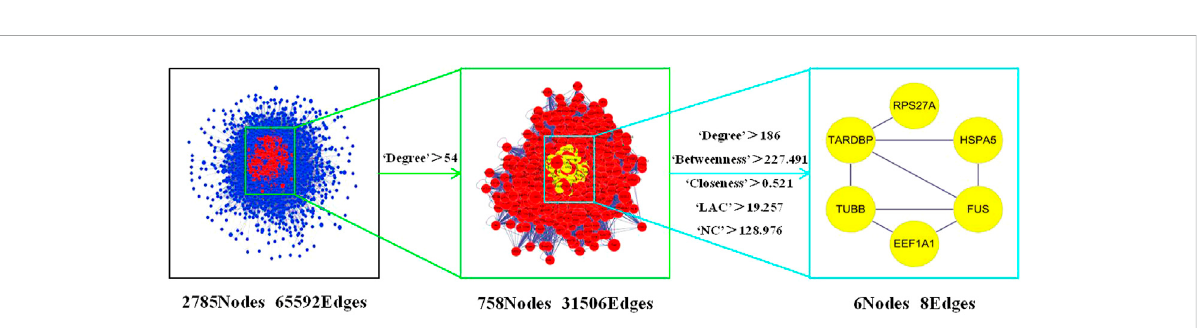
FIGURE 4 PPI network of target protein related to migraine and Ligusticum chuanxiong-Piper longum couplet medicines and fl ow chart of the screening target protein.